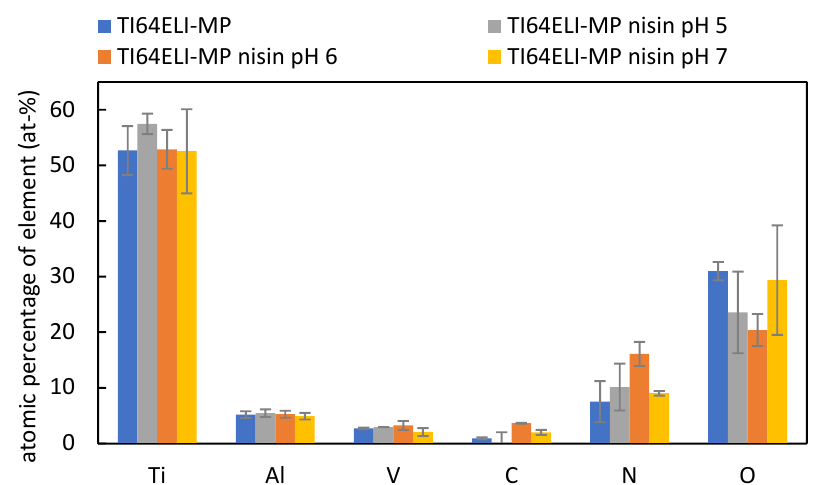
Figure 2. EDS analysis of MP samples, both bare and functionalized surfaces with processes at different pH values (pH = 5/6/7).